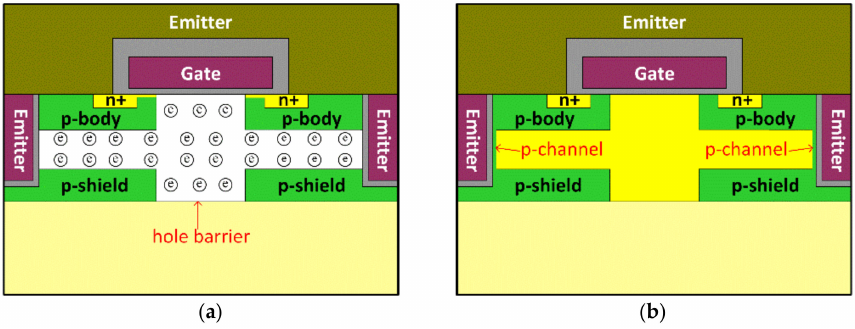
Figure 6. Operation mechanism analysis of the proposed IGBT in ( a ) on-state and ( b )